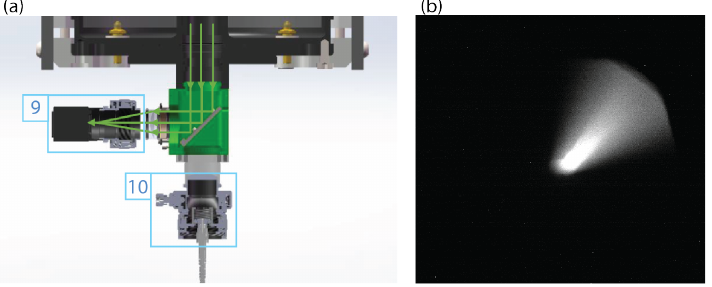
Figure 4. ( a ) Schematic diagram illustrating how the camera is used for lidar alignment. ( b ) Camera image of aligned